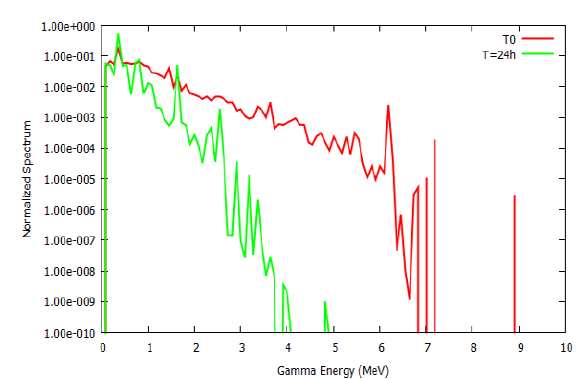
Figure 5. Gamma spectrum for two cooling durations (O and 1 day)